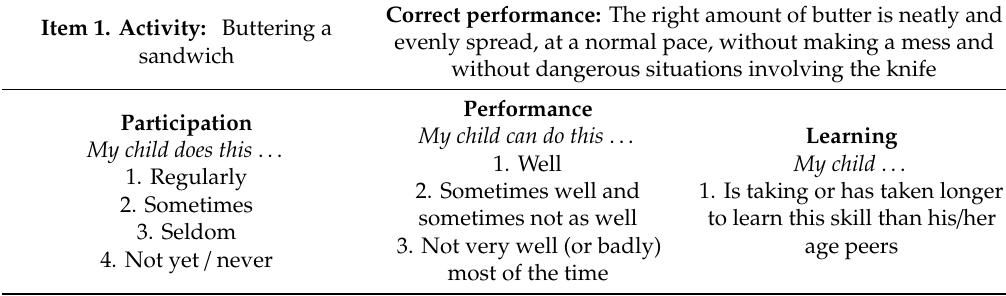
Table A1. Illustrative item of the DCDDaily-Q.